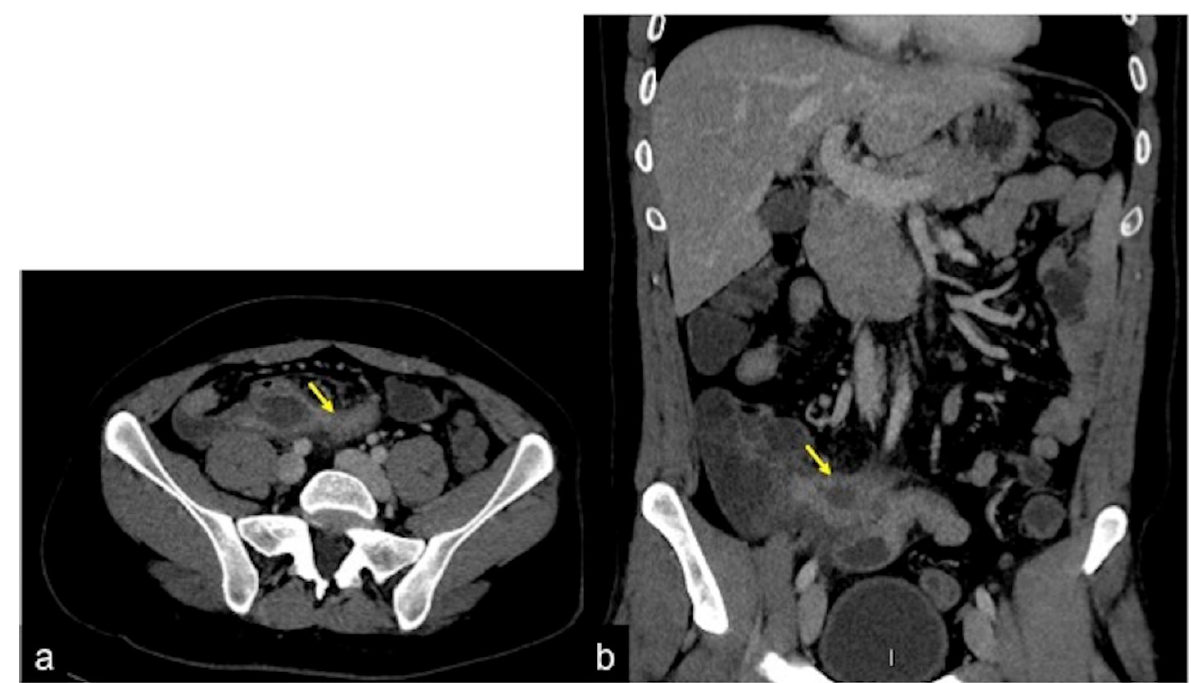
Figure 39. CTA axial ( a ) and coronal ( b ) images in the venous phase show inflammatory stenosis of terminal ileum (( a ) arrow) in Crohn’s disease complicated by an abscess (( b ) arrow).